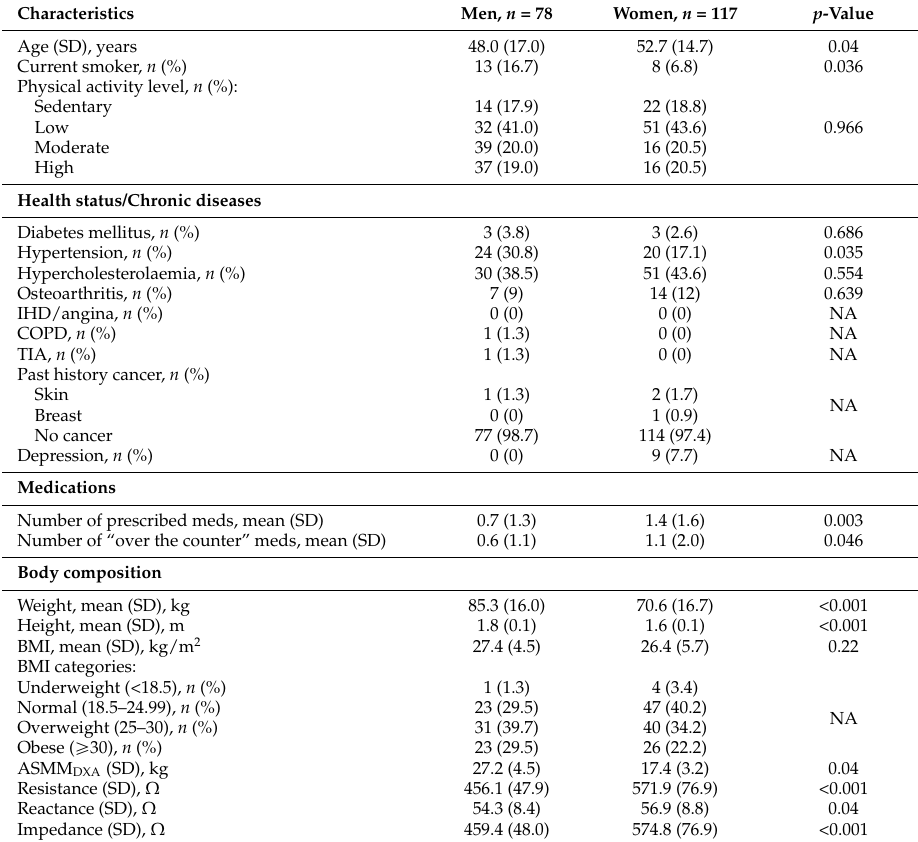
Table 2. General characteristics of the CASA